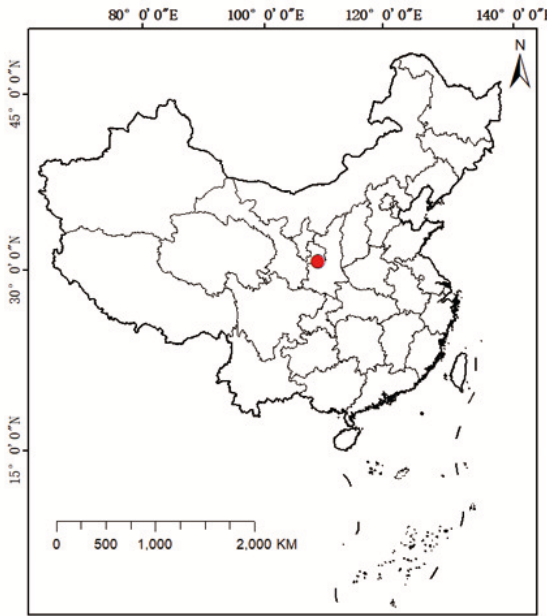
Figure 1. Location of Chang Wu Agroecological Experimental Station. The red dot shows the location of the experimental site in China.